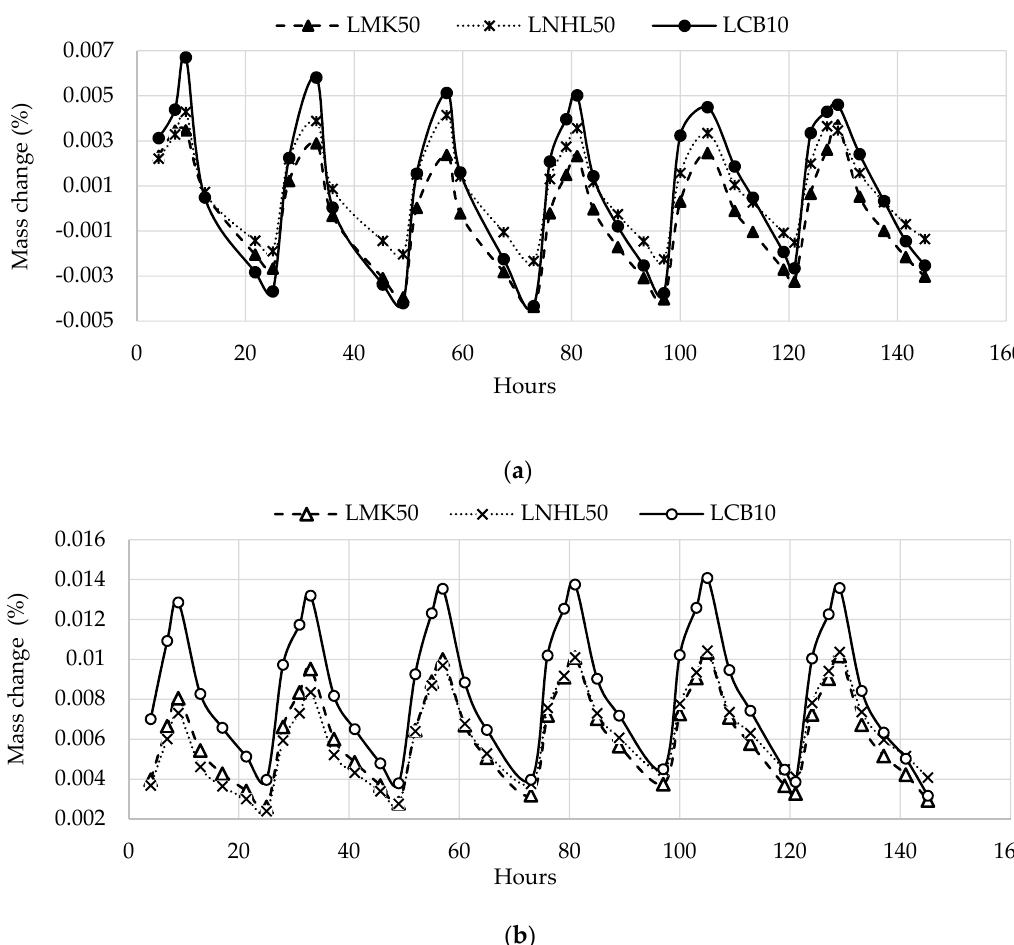
Figure 6. Typical steady cycle with different boundary conditions. ( a ) High moisture content initial condition; ( b ) Low moisture content initial condition.